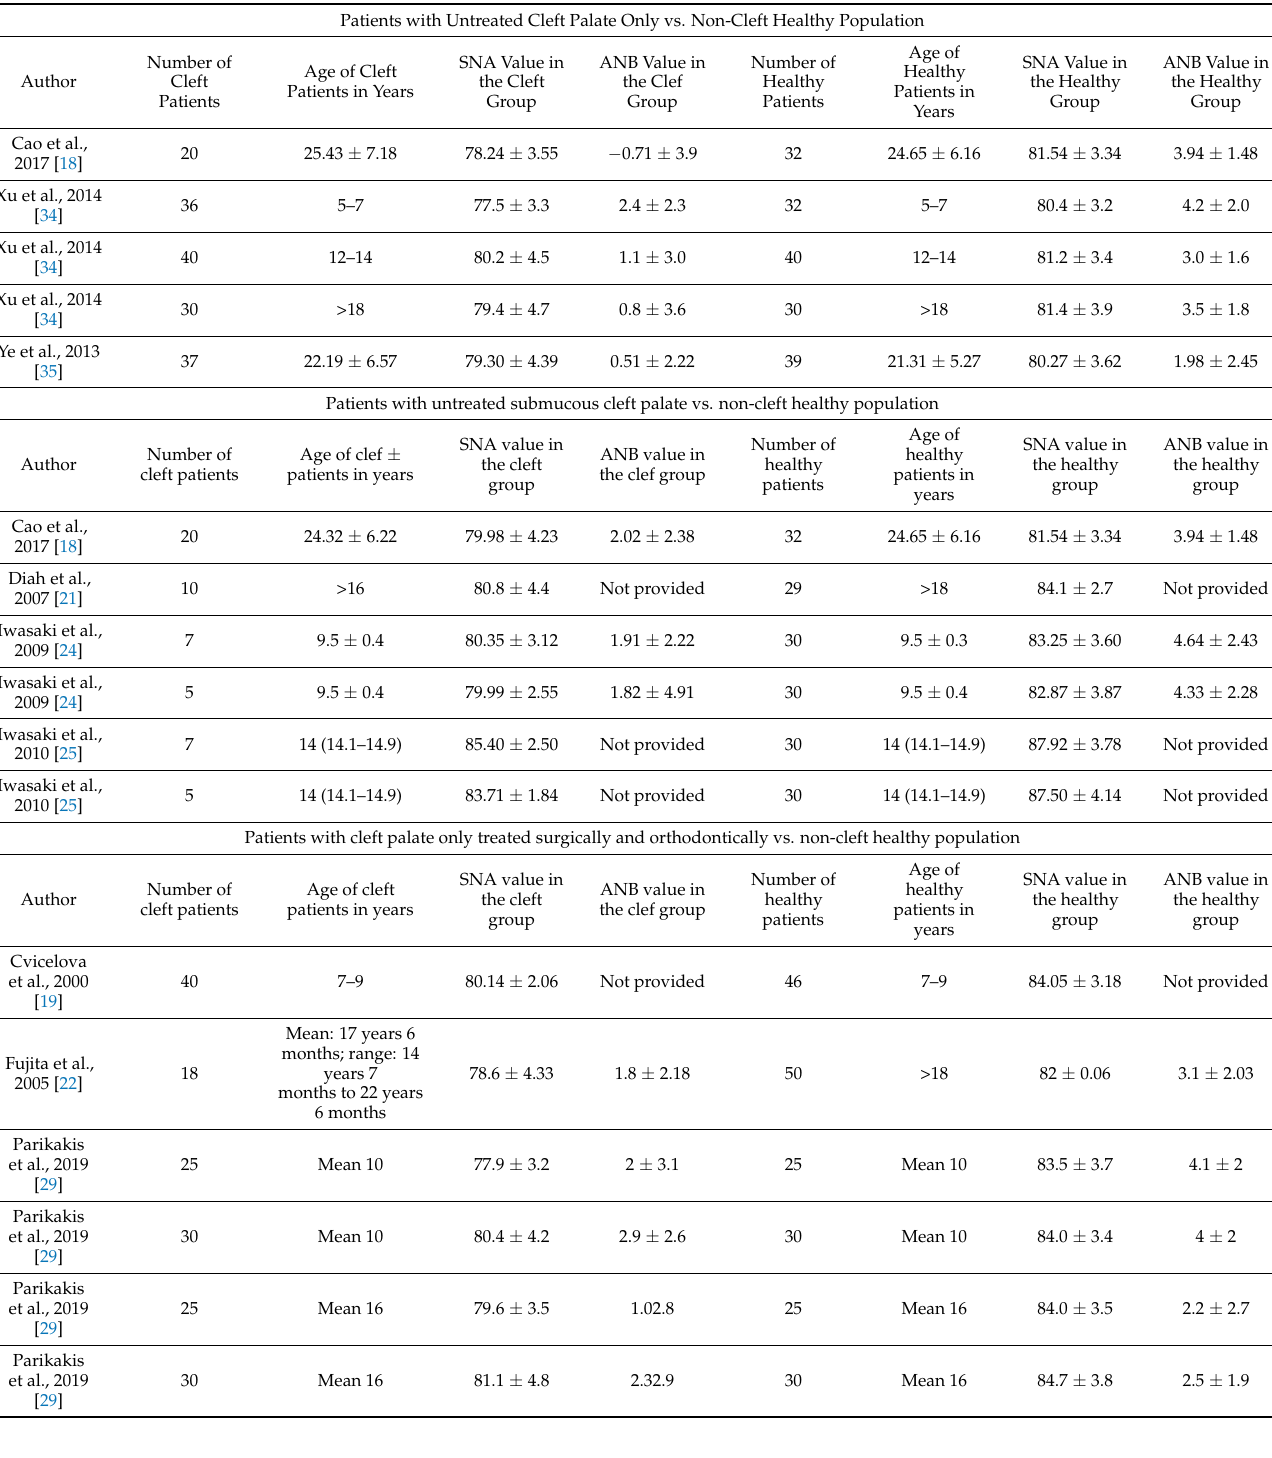
Table 3. Extracted data subjected to